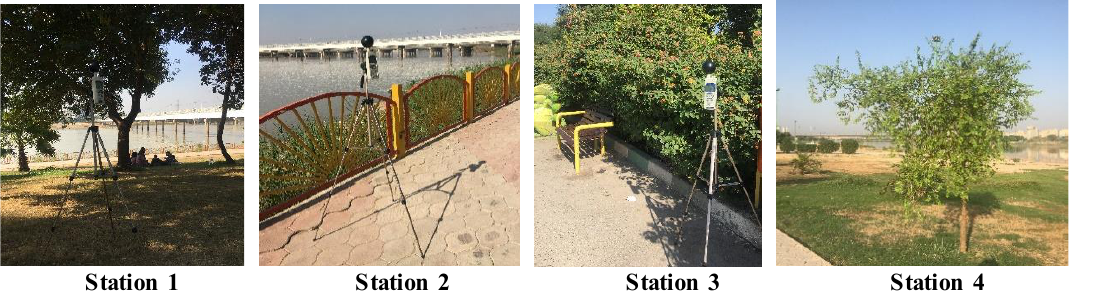
Figure 1. Pictures of selected stations for the project Figure 1: Pictures of Selected Stations for the Project